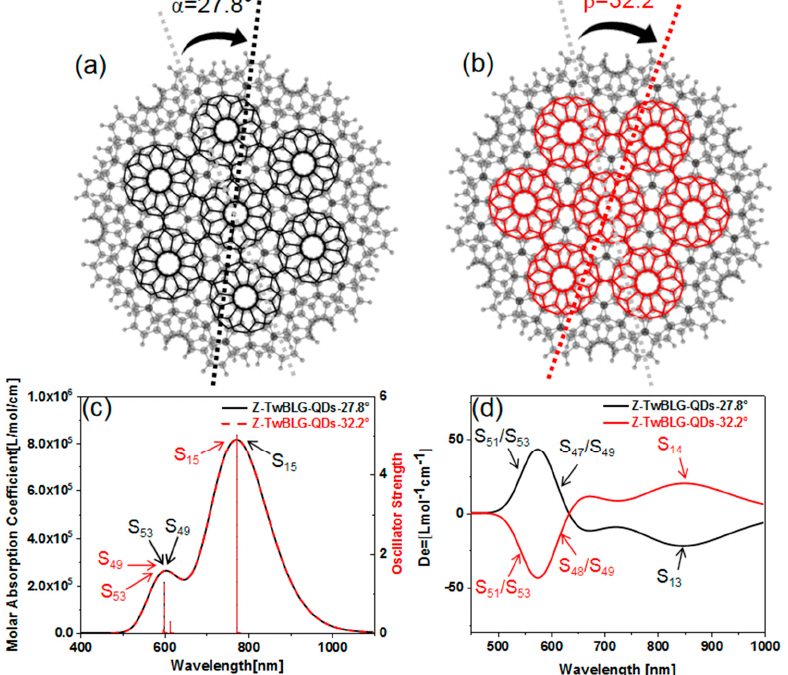
Figure 1. Molecular structures of Z-TwBLG-QDs-27.8° and Z-TwBLG-QDs-32.2° ( a , b ). The theoret- ical calculation of combined UV–vis and ECD of Z-TwBLG-QDs-27.8° and Z-TwBLG-QDs-32.2° ( c , d ). calculation of combined UV–vis and ECD of Z-TwBLG-QDs-27.8